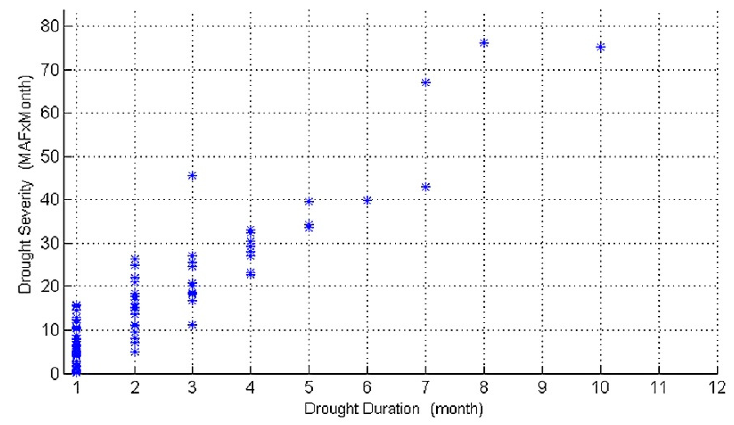
Figure 8. Truncated drought events (1560 to 1977) using observed and reconstructed streamflow.